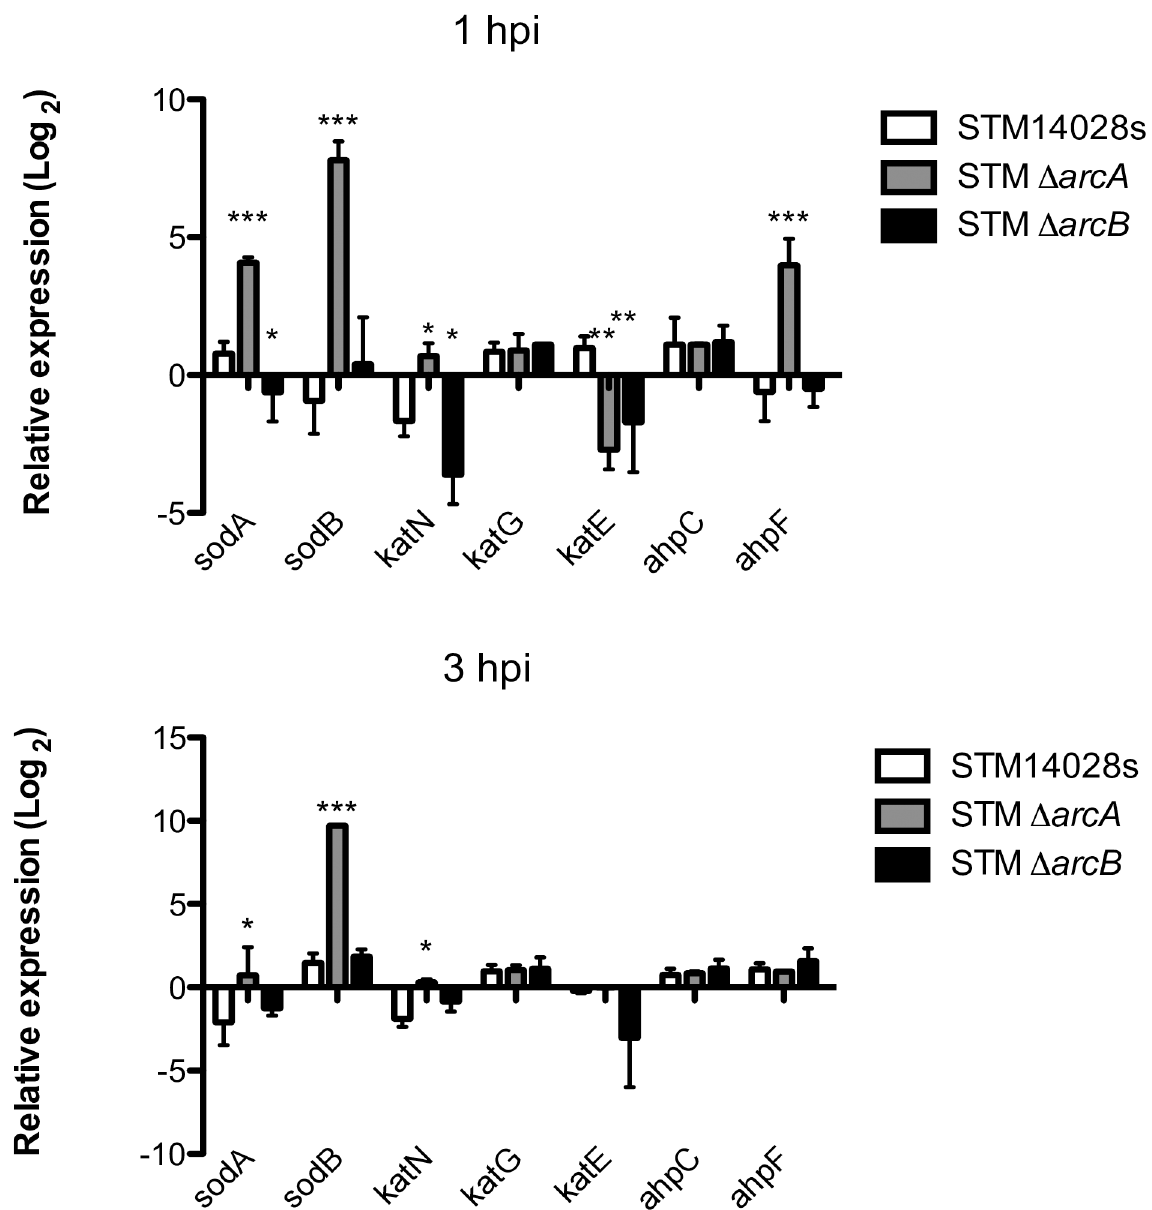
Fig 4. Relative expressions of genes related to detoxification ( sodA , sodB , katN , katG , katE , ahpC and ahpF ) in S . Typhimurium Δ arcA and Δ arcB strains inside bone-marrow-derived murine neutrophils. (cid:3) P < 0.05; (cid:3)(cid:3) P < 0.01; (cid:3)(cid:3)(cid:3) P < 0.001. One-way ANOVA with the Bonferroni correction comparing mutant strains with a wild type strain separately at 1 and 3 h postinfection. Biological replicates n = 5, three technical replicates per experiment.